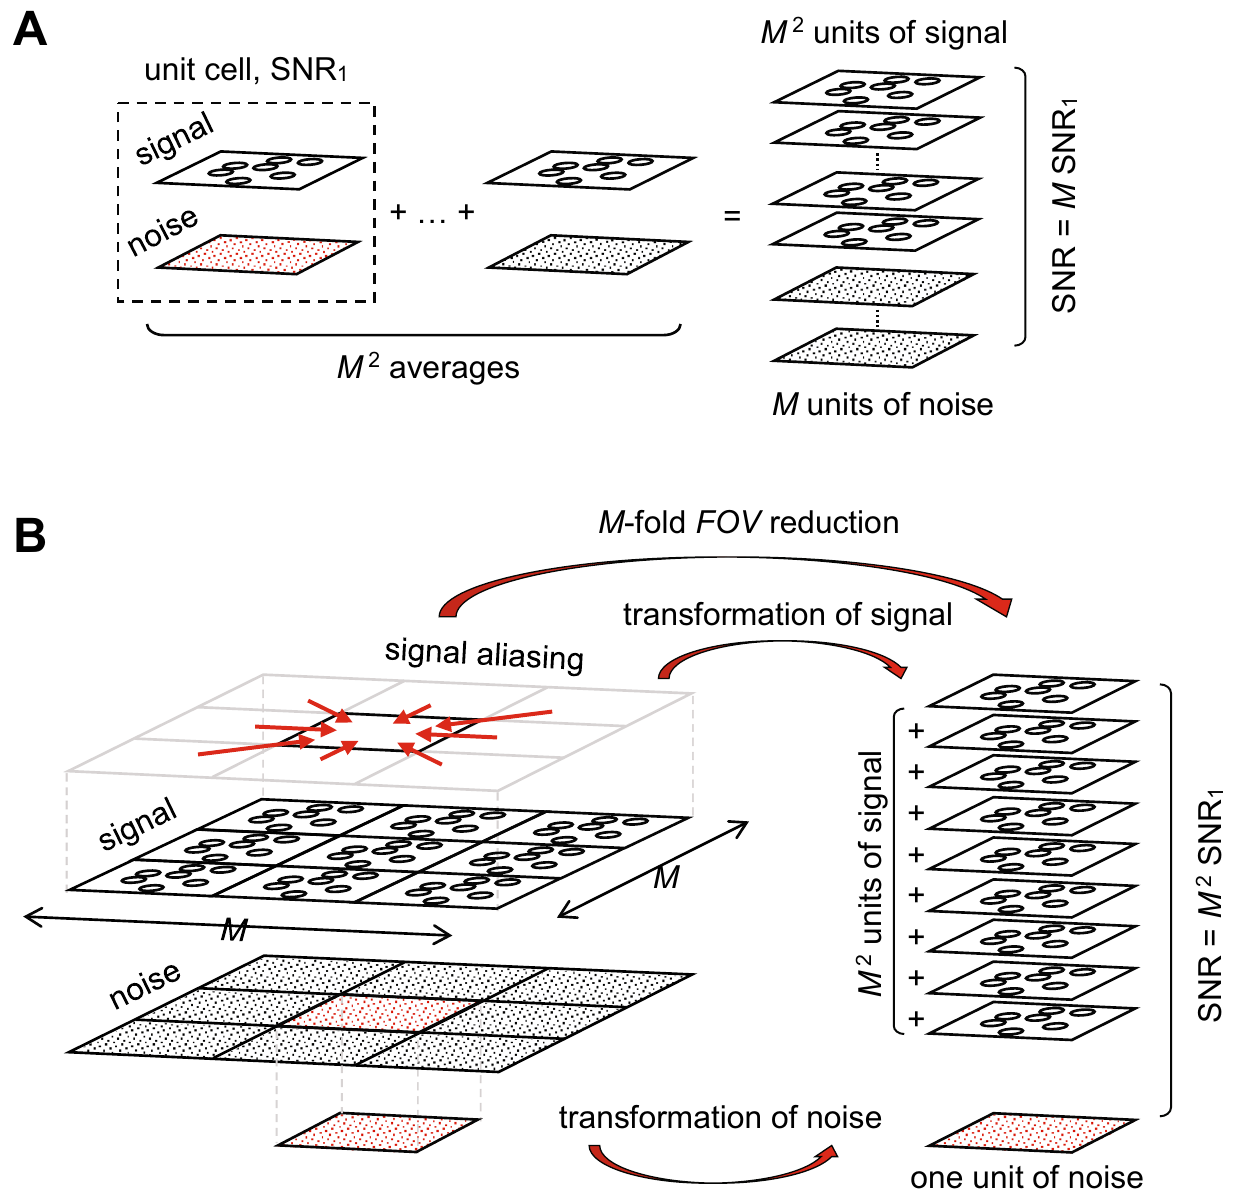
Figure 1. Standard signal averaging vs. constructive signal aliasing. Schematic presentation of the mechanism 2 of SNR increase ( A ) in standard signal averaging and ( B ) in constructive signal aliasing. When signals of M 2 images are averaged the signal increases by a factor of M , however, noise also increases by a factor of M , so that the SNR increase is M -fold. In the constructive signal aliasing approach, imaging of a periodic sample with 2 unit cells arranged in a M × M matrix results in the signal increase by a factor of M , while there is no change in 2 image noise, so that the SNR increase is M